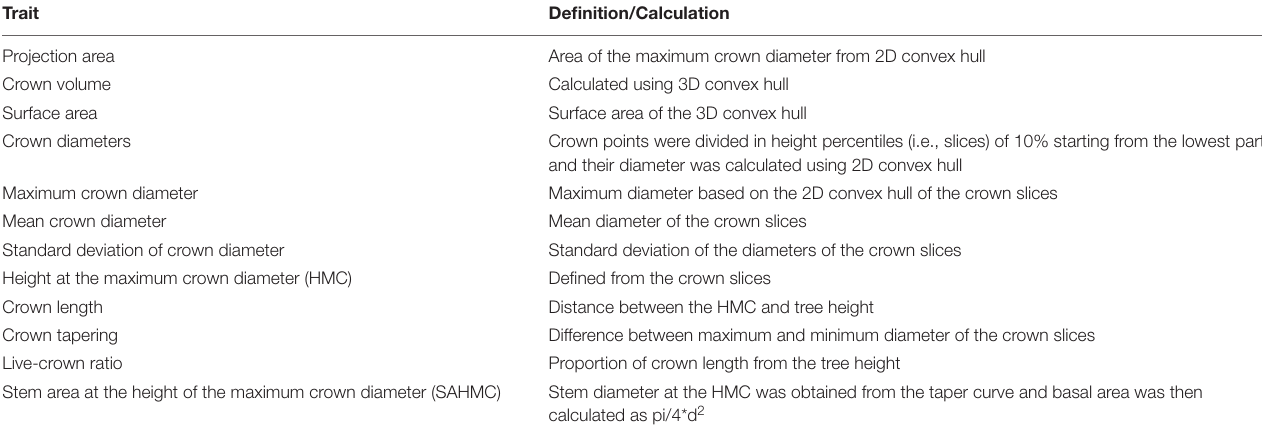
TABLE 3 | Crown traits and how they were defined and/or generated from TLS point